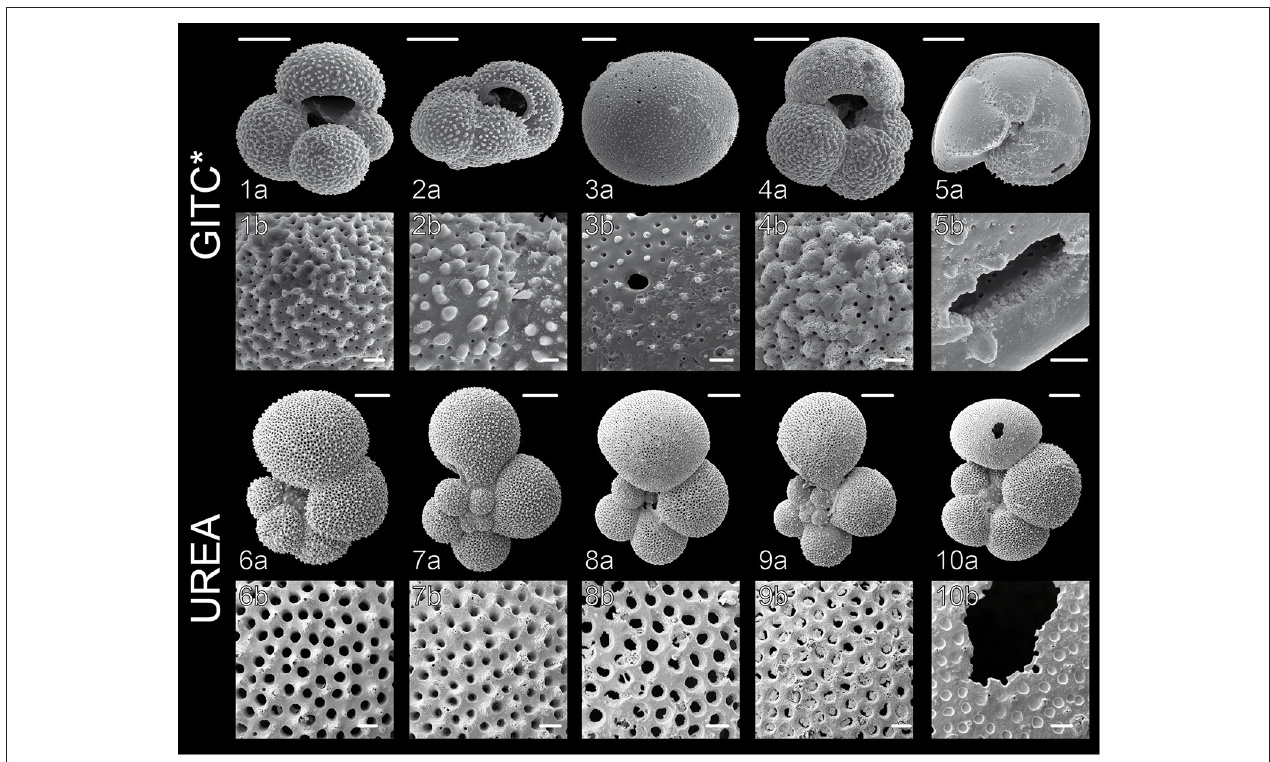
FIGURE 3 | Scanning Electron Microscope (SEM) images of planktonic foraminiferal shells after DNA extraction, carried out according to the GITC* and urea protocols. (1) G. bulloides Type IIb, South Indian Ocean (from Morard et al., 2013), (2) G. inflata Type I, South Indian Ocean, (3) O. universa Type III, West Pacific, (4) G. bulloides Type IIg, South Indian Ocean, (5) G. truncatulinoides Type I, South Pacific, (6) G. siphonifera Type IIa5, Mozambique Channel (from Weiner et al., 2015), (7) G. calida Type IIIb, Mozambique Channel, (8) G. siphonifera Type Ib, Mozambique Channel, (9) G. radians Type Ia, Mozambique Channel (from